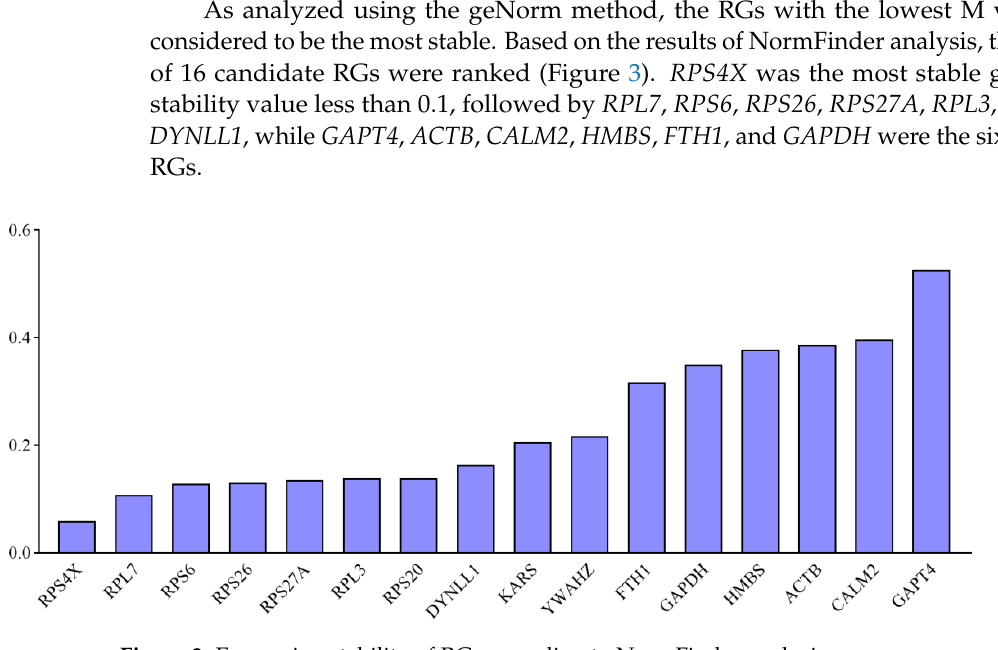
Figure 3. Expression stability of RGs according to NormFinder analysis.